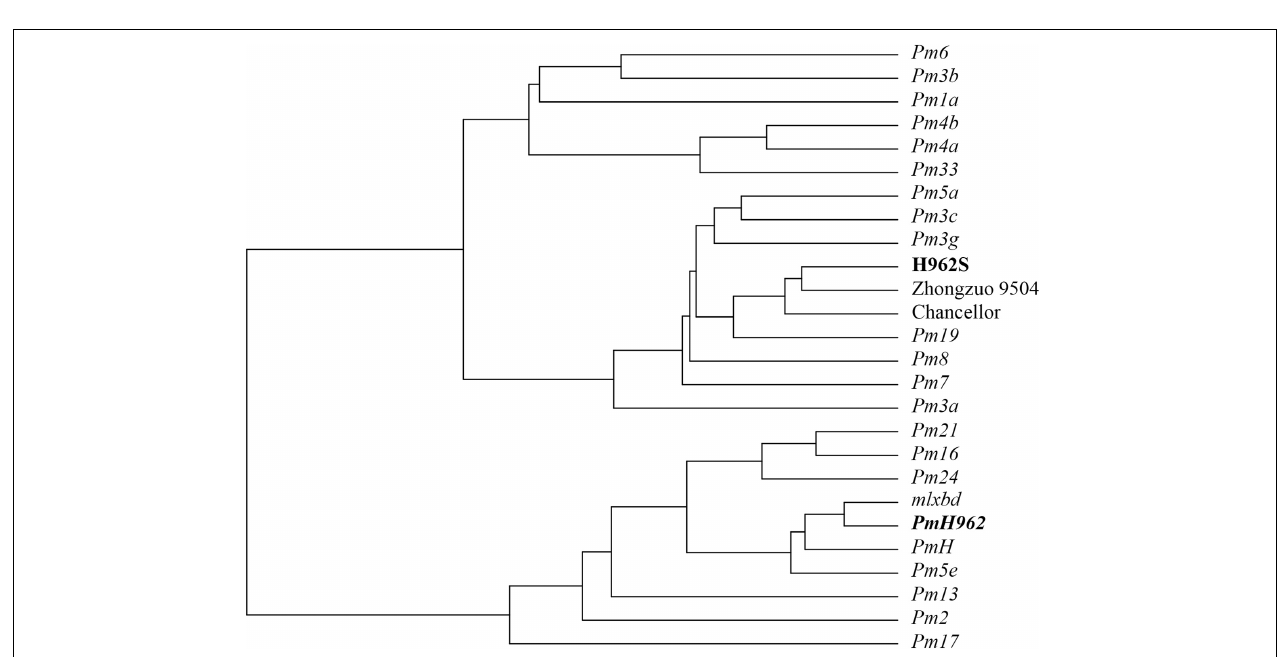
FIGURE 1 | Diagram of chromosomal compositions for H962R and H962S by 16K GBTS SNP array (A) and 90K Illumina iSelect Wheat SNP array (B) . The blue and red lines represent the same and different SNPs between H962R and H962S, respectively. The centromeres are indicated by the gray dots.